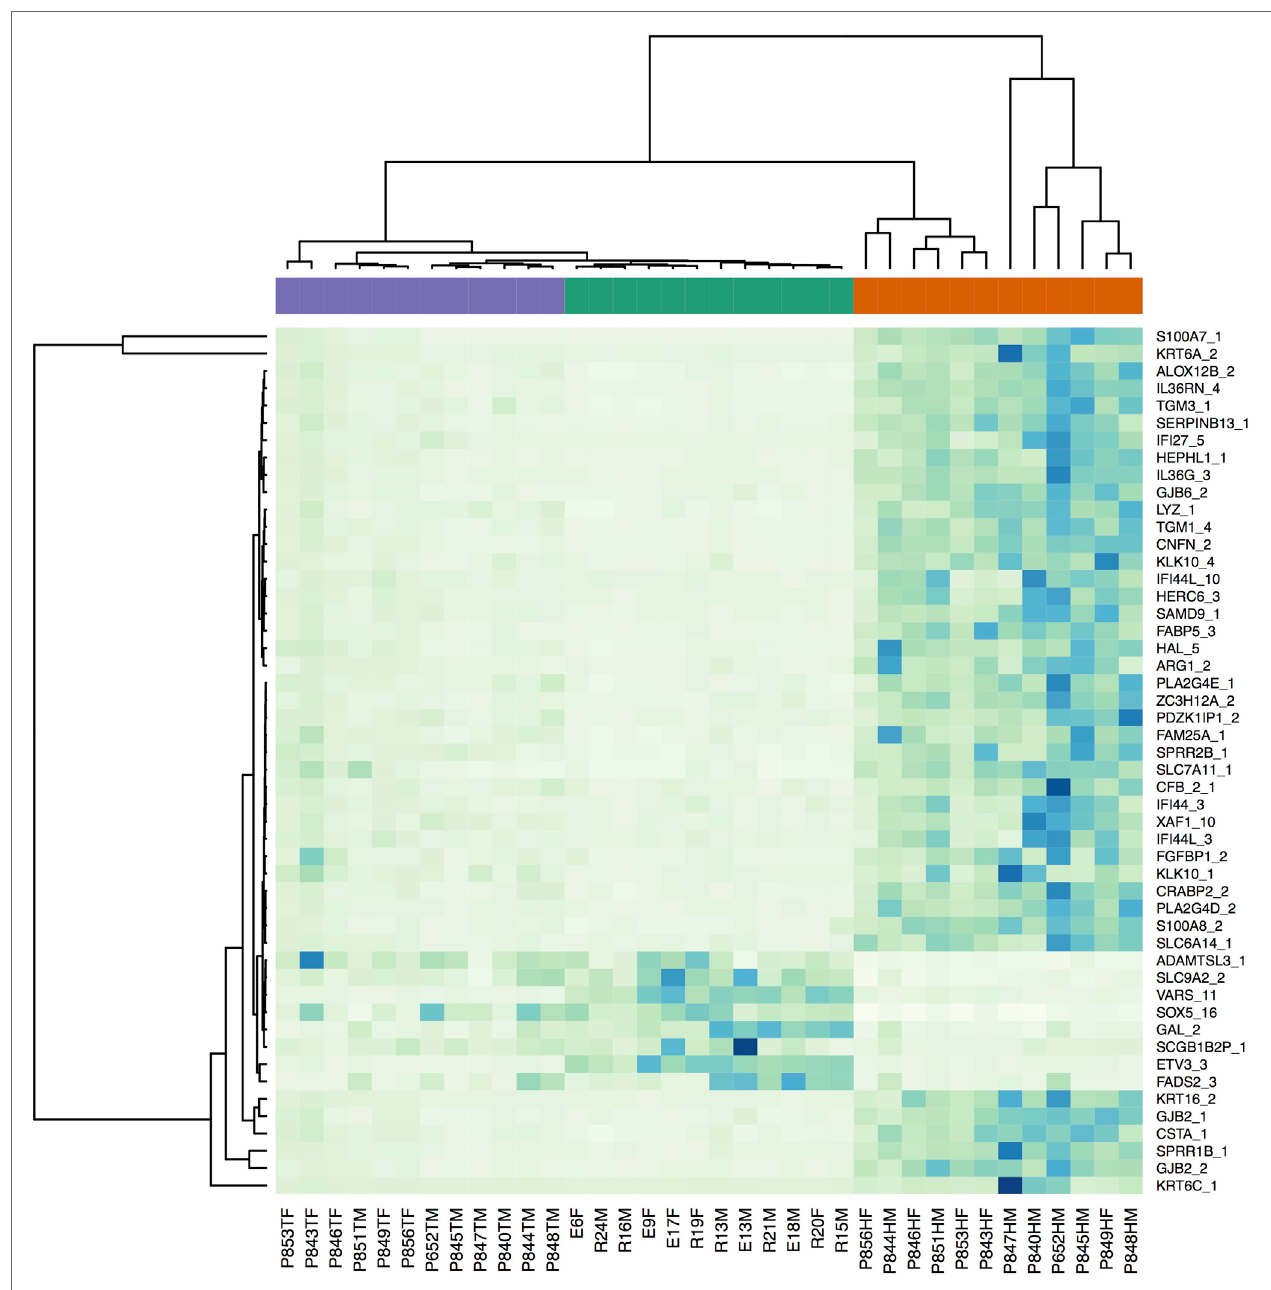
FigUre 1 | heatmap of the rna-seq expression data for the 50 transcripts with the smallest FDr values (lP–c comparison) illustrating differences in transcriptional profiles . The violet bar denotes non-lesional skin samples, the green bar controls, and the red bar lesional samples.